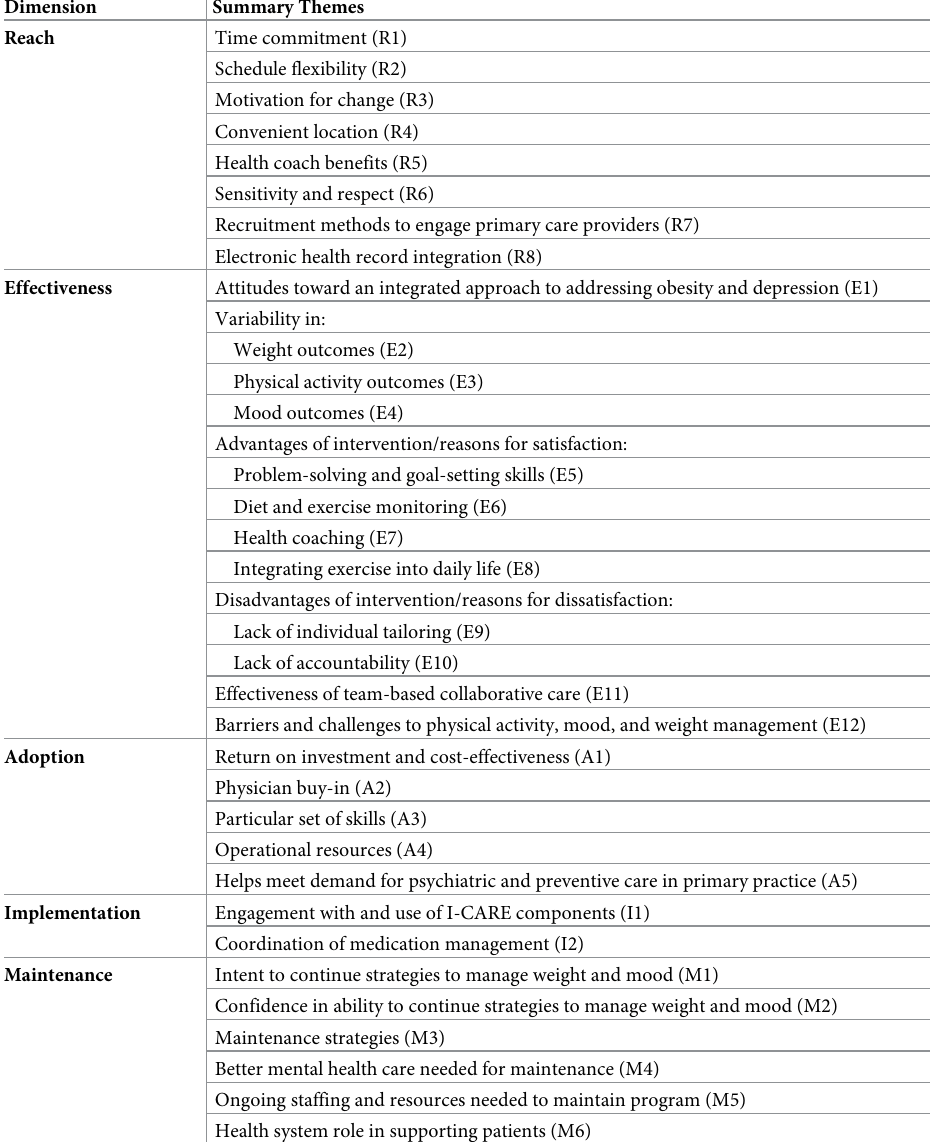
Table 5. Summary of themes across each RE-AIM